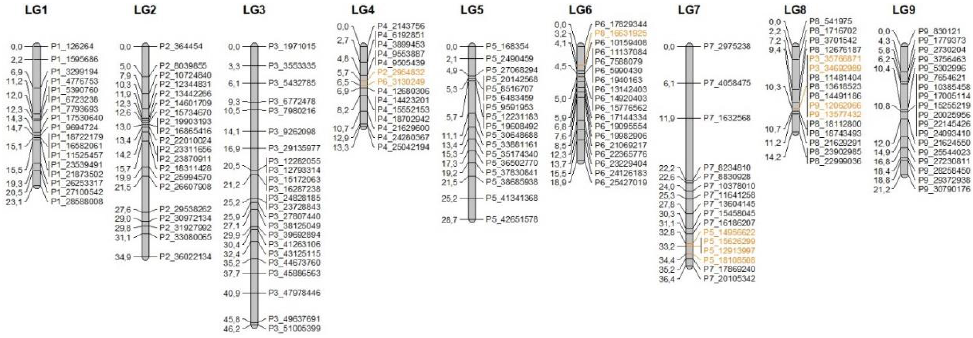
Figure 4. Genetic map of the tetraploid 4475 citrumelo. The non-syntenic markers are in orange. Details of LG (Linkage Group) are presented in Table 2.